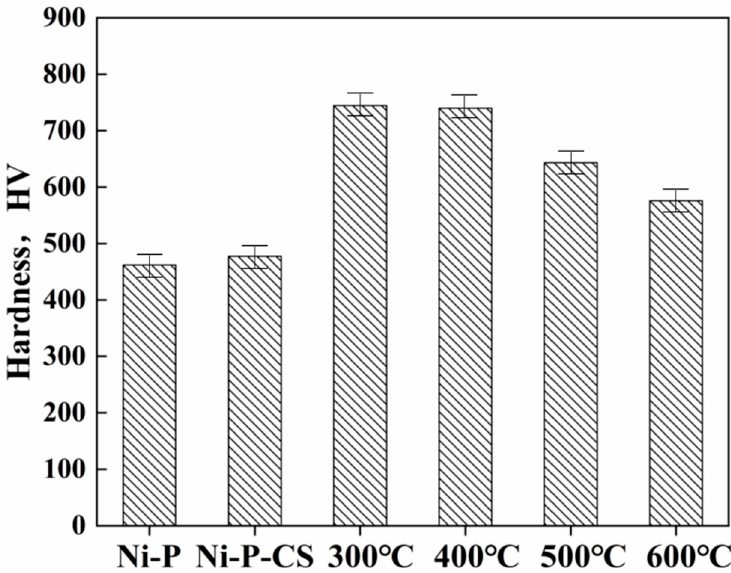
Figure 5. Microhardness of Ni-P and Ni-P-CS (after heat treatment at different temperatures).